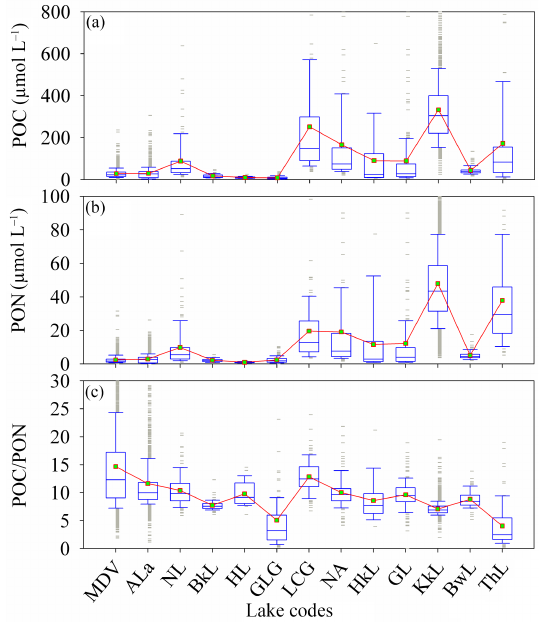
Figure 7. Variation of PON, POC and POC / PON in lake wa- ters. The lakes are mainly located in the Northern Hemisphere. Eu- trophic, small, large, and shallow lakes are included in the dataset. MDV is McMurdo Dry Valleys Lakes (Antarctica), ALa is Alaskan Lakes (USA), NL is Norwegian Lakes (Norway), NA is Northern American Lakes (USA), HkL is Hokkaido Lakes (Japan), LCG is the Lacustrine Central Group (USA), KkL is Lake Kasumigaura (Japan), BwL is Lake Biwa (Japan), HL is Lake Hovsgol (Mongo- lia), BkL is Lake Baikal (Russia), GL is Green Lake (Canada), ThL is Lake Taihu (China), and GLG is the Great Lakes Group (USA). The box plots show the median and 25th and 75th percentiles, with whiskers covering most of the data. The red line with green boxes shows the mean value of each range. The lake names and their ab- breviations are listed in Table S7 in the